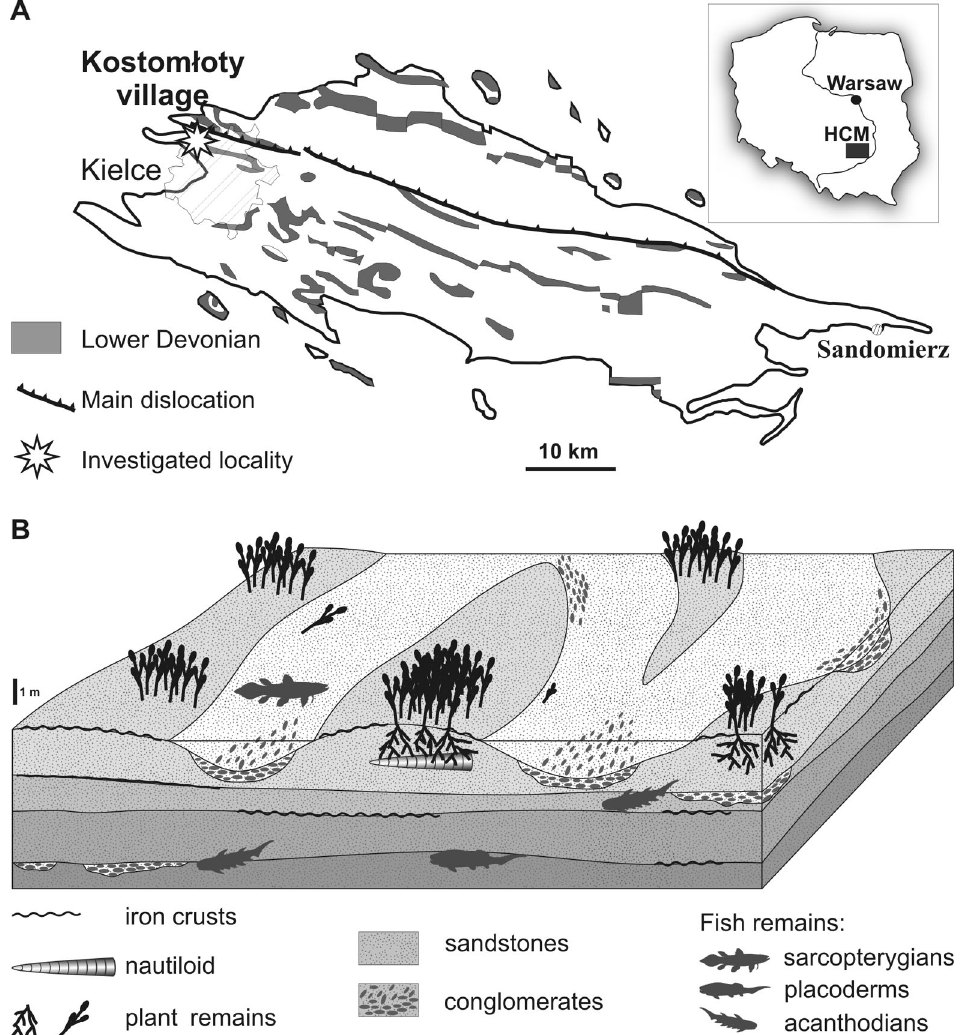
Fig. 1. A , location of Kostom ł oty in the Holy Cross Mountains (HCM), Central Poland (after Kowalczewski 1971, fig. 1 (cid:150) modified); B , block diagram showing the investigated profile near Kostom ł